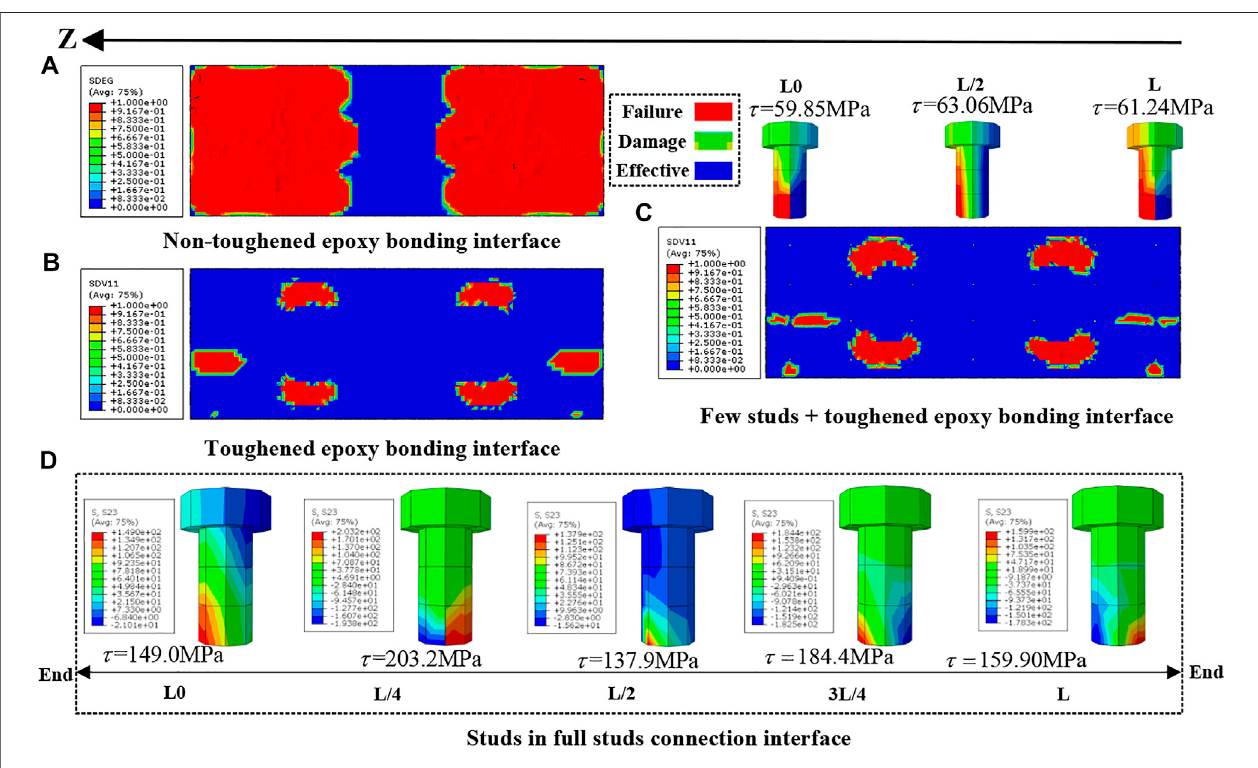
FIGURE 12 | Interface stress and failure distribution under 5 times the standard wheel load. (A) Non-toughened epoxy bonding interface. (B) Toughened epoxy bonding interface. (C) Few studs + toughened epoxy bonding interface. (D) Studs in the full stud connection interface.